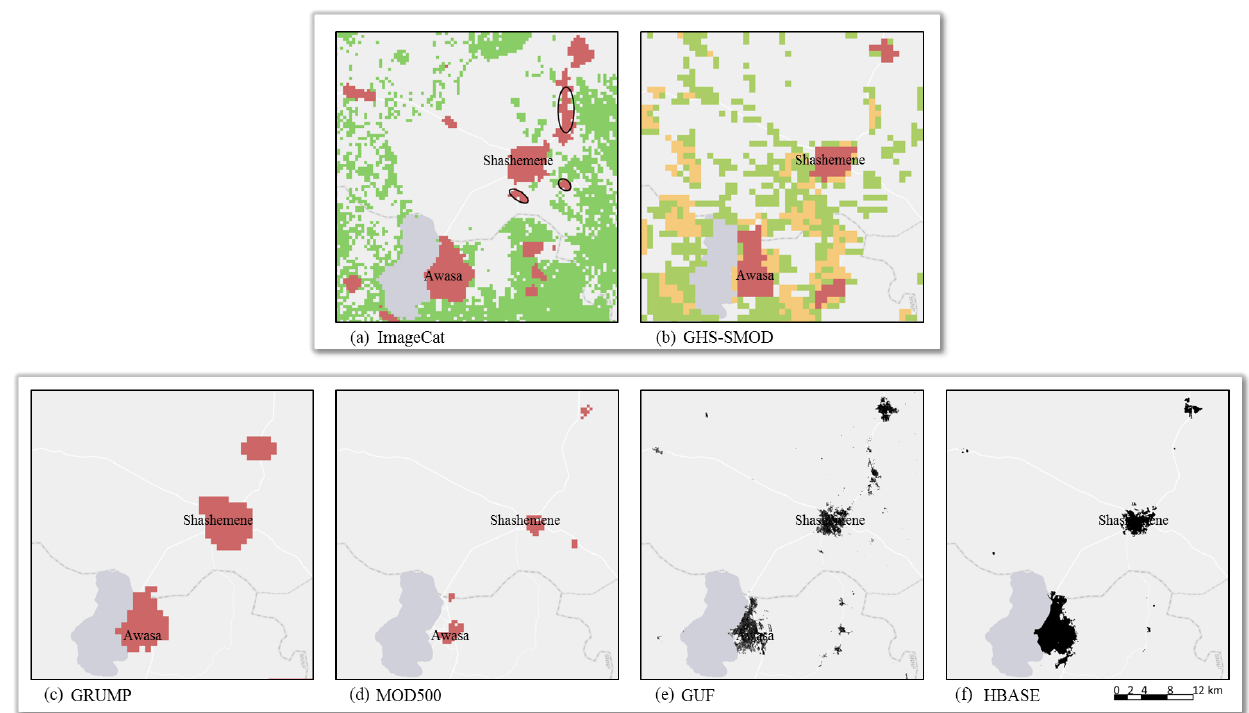
Figure 4. Illustration of urban–rural land use in the greater Awasa area in Ethiopia: (a) urban (red) and rural (green) classified ImageCat data; (b) GHS-SMOD urban centre (red), urban cluster (yellow), and rural (green); (c) GRUMP urban extent (red); (d) MOD500 urban extent (red); (e) GUF built-up area (black); (f) HBASE built-up area and settlements (black); original dataset projections. Source background map: Esri, HERE, DeLorme, MapmyIndia, © OpenStreetMap contributors, and the GIS User Community. © OpenStreetMap contributors 2019. Distributed under a Creative Commons BY-SA License. Table 6. Results of map agreement for Ethiopia using the ImageCat data classified as urban, rural, and other land use as the reference map. Urban Rural Other land use Urban–rural map Producer’s User’s Producer’s User’s Producer’s User’s Overall Kappa accuracy accuracy